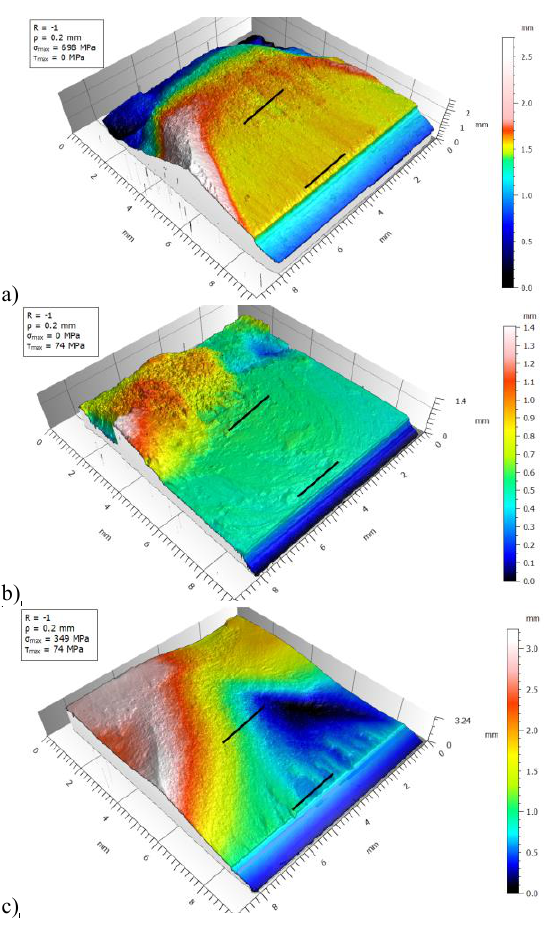
Fig. 5. EN AW-2017A-T4 specimens with marked crack propagation and rupture roughness profiles, for exemplary specimens loadings subjected to a) bending, b) torsion, c) bending with torsion.